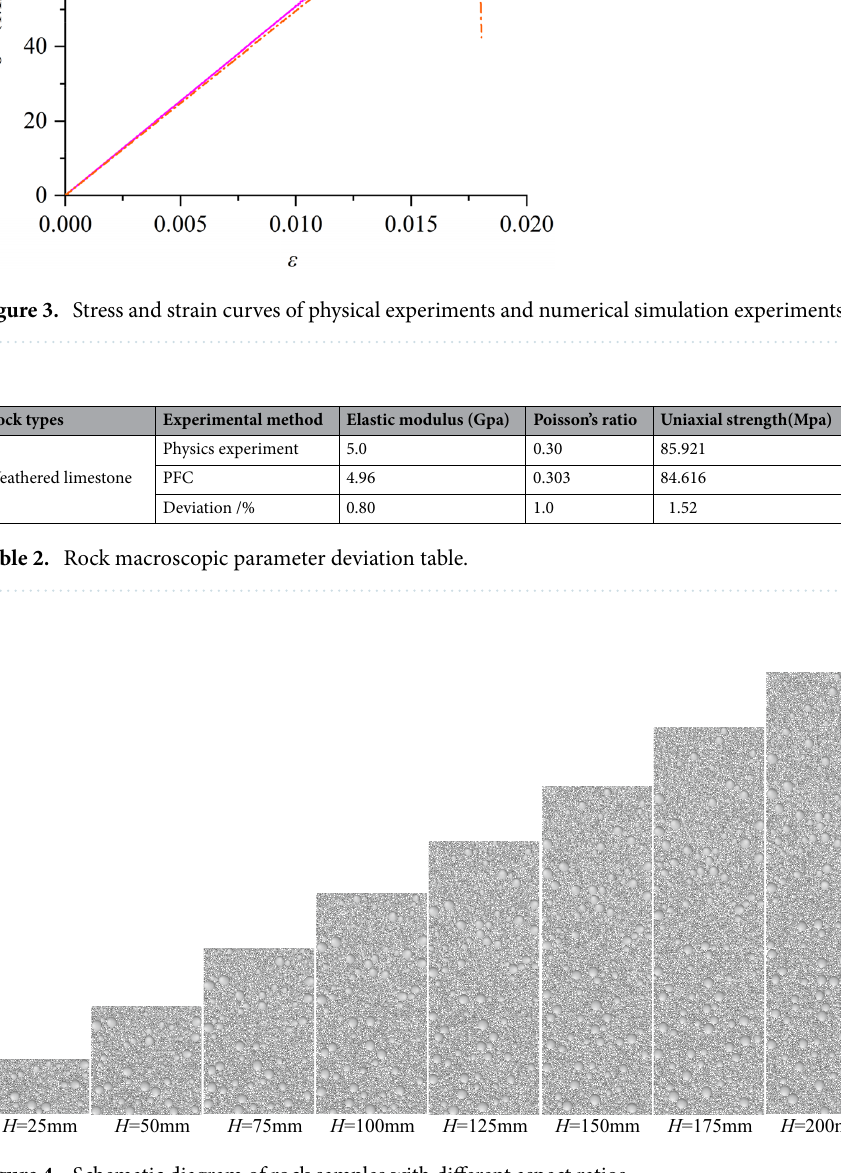
Figure 4. Schematic diagram of rock samples with different aspect